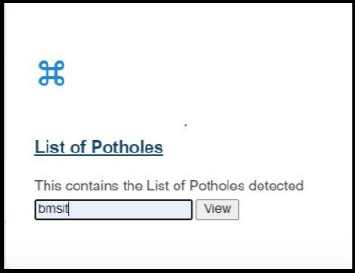
Figure 9 . List of Potholes on the Application Figure